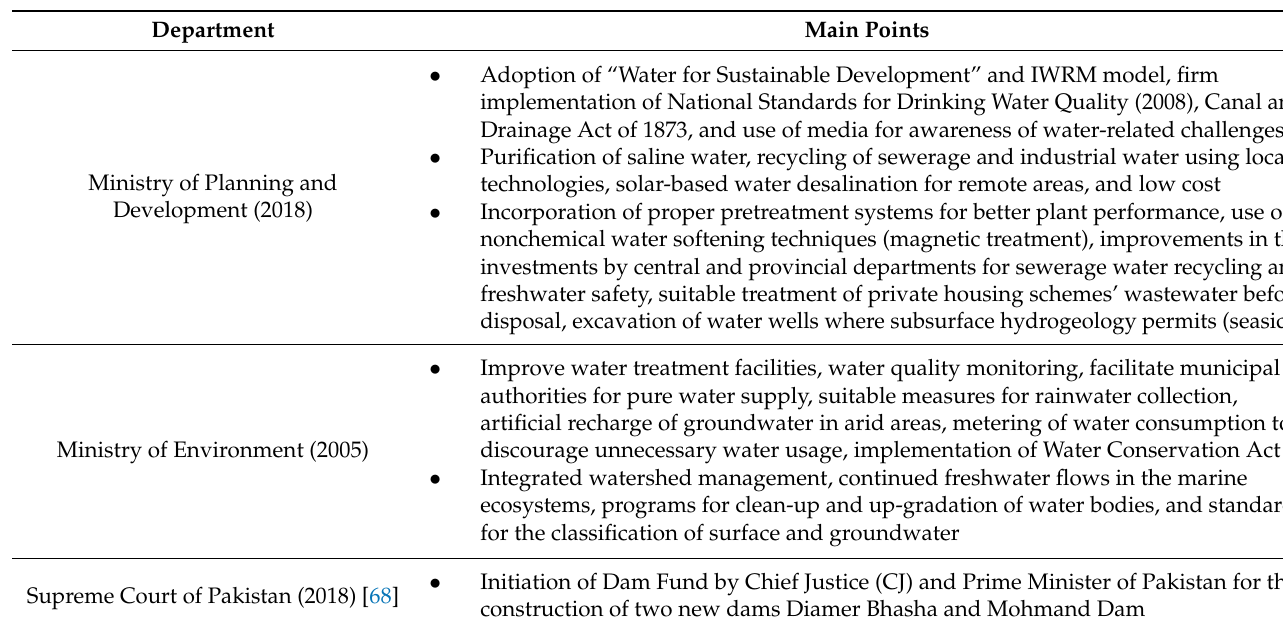
Table A2. Government plans related to water issues [66–68].